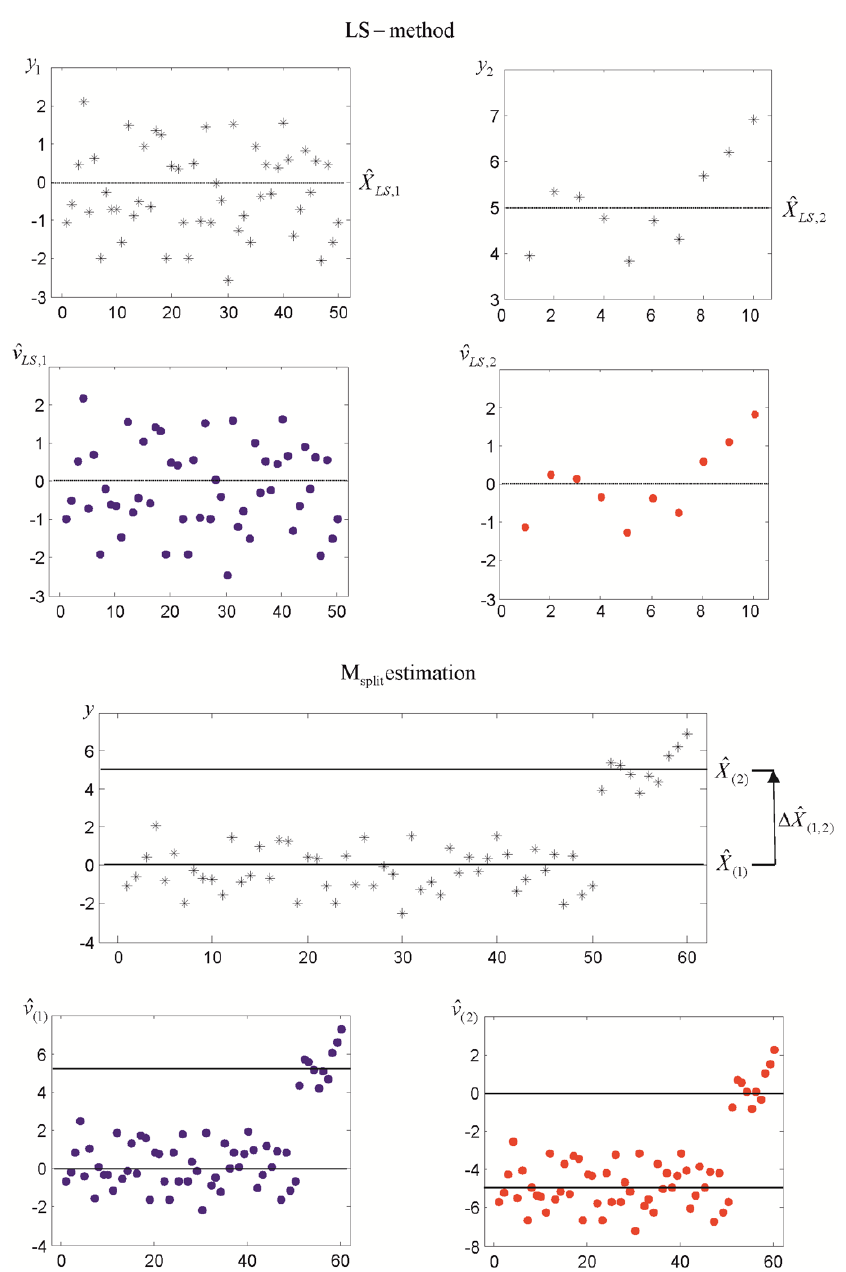
Figure 2. LS estimates, M split estimates, and respective residuals (elementary functional models for ∆ X 5 X ). ( 1 , 2 ) ( 1,2 ) =